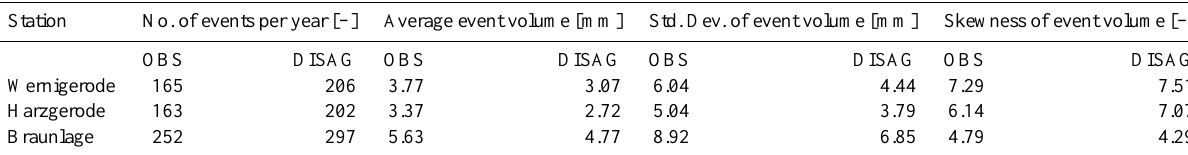
Table 3. Event characteristics for three selected rainfall stations (see Fig. 6) from 14yr OBS and 10 × 14yr DISAG rainfall; OBS statistics estimated from data with missing values replaced by data from neighbor stations.